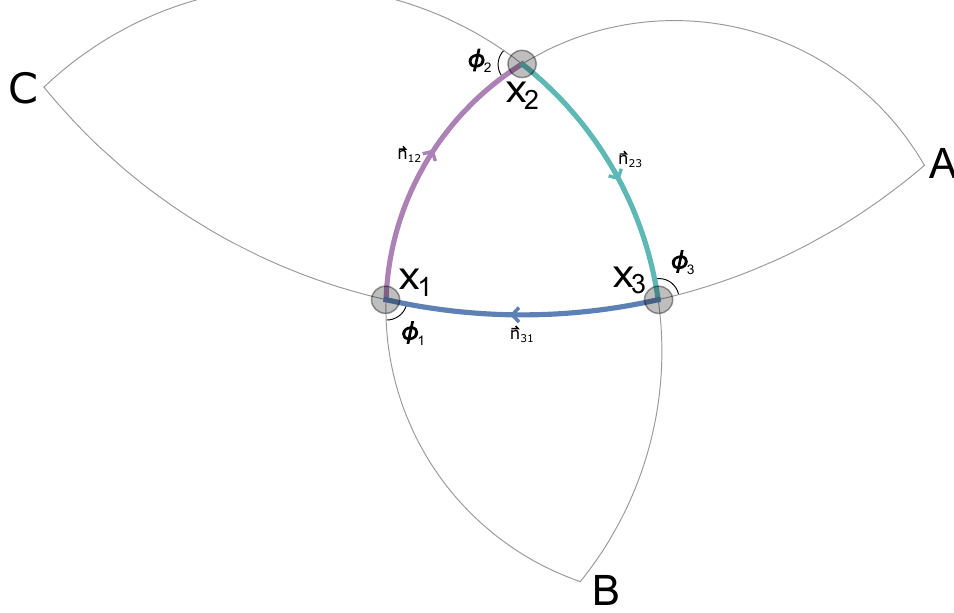
Figure 7 . The general con(cid:12)guration of the Wilson loop we consider (the x 1 x 2 x 3 triangle) is built out of 3 circular arcs belonging to the same plane. The con(cid:12)guration is parameterized by 3 external angles (cid:30) i , coordinates of the vertices x i and 3 scalar products of the unit vectors attached to the scalars inside the Maldacena-Wilson loop (or equivalently 3 couplings ^ g a ). Pairs of arcs continued outside the triangle intersect again at A , B and C . The renormalized 3-cusp correlator has the typical CFT dependence on the positions of the vertices, with a structure constant which depends only on the 3 angles and 3 couplings. In this paper we only consider the case with two non-zero